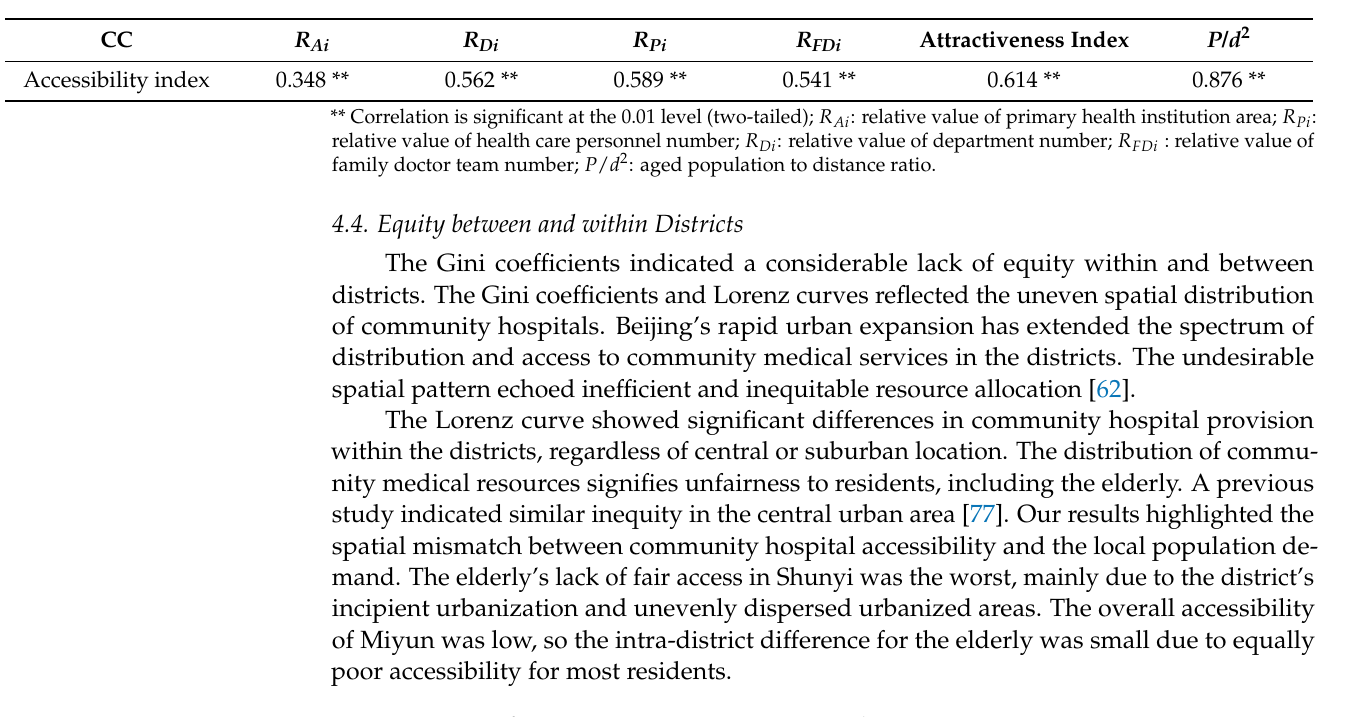
Table 4. Spearman correlation coefficients between accessibility index, attractiveness index and associated